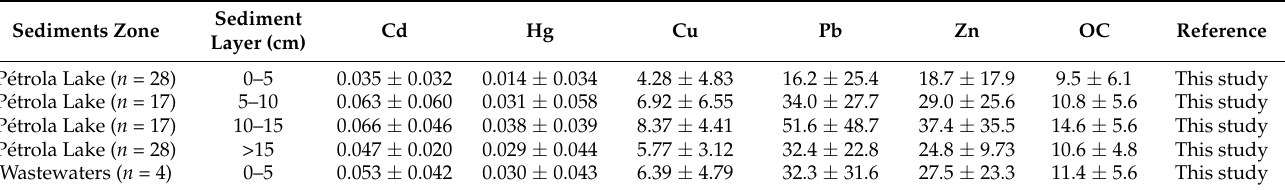
Table 1. Mean ( ± SD) concentrations of heavy metals (mg/kg dry weight) and organic matter content (OC, %), and comparison with other locations and sediment quality guidelines. ERM: effects range median. ISQG: